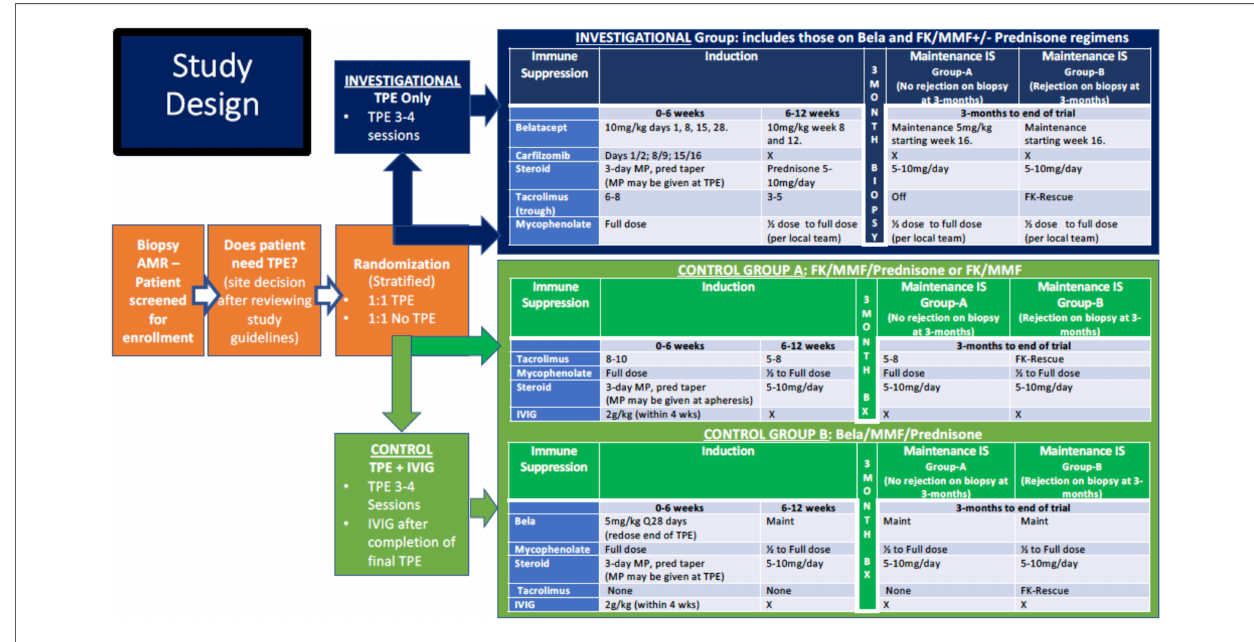
FIGURE 3 CTOT42 CarBel protocol